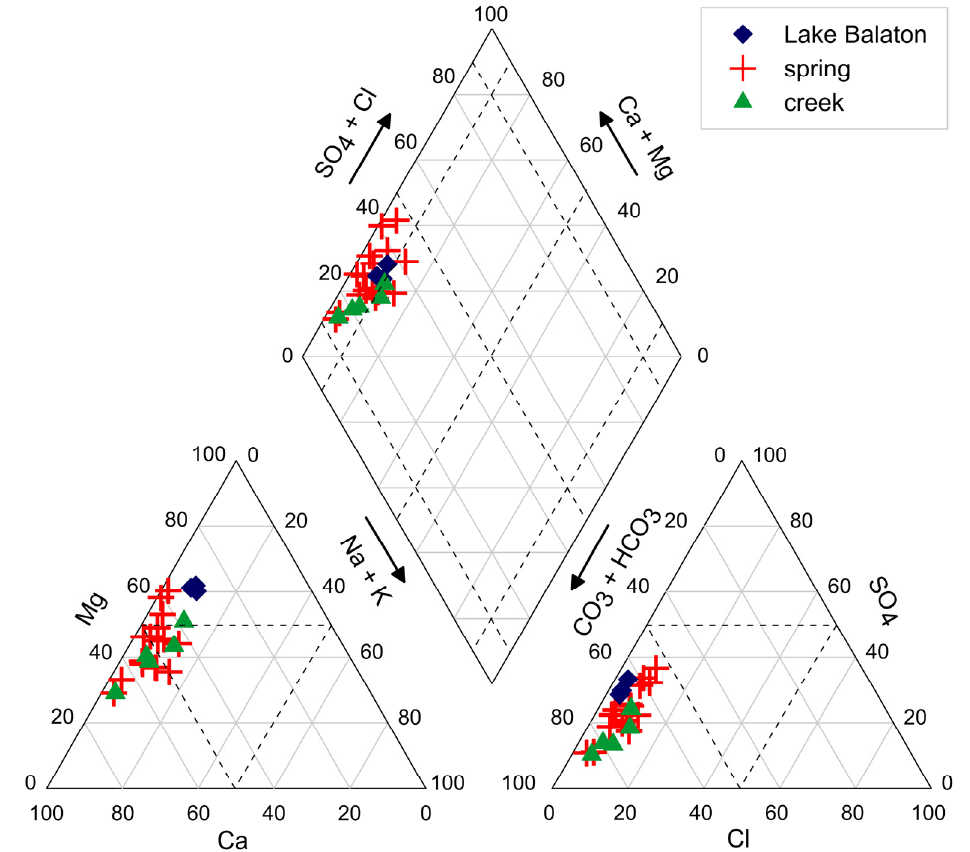
Figure 6. Piper diagram of water